Question: What caption would you write for this figure?
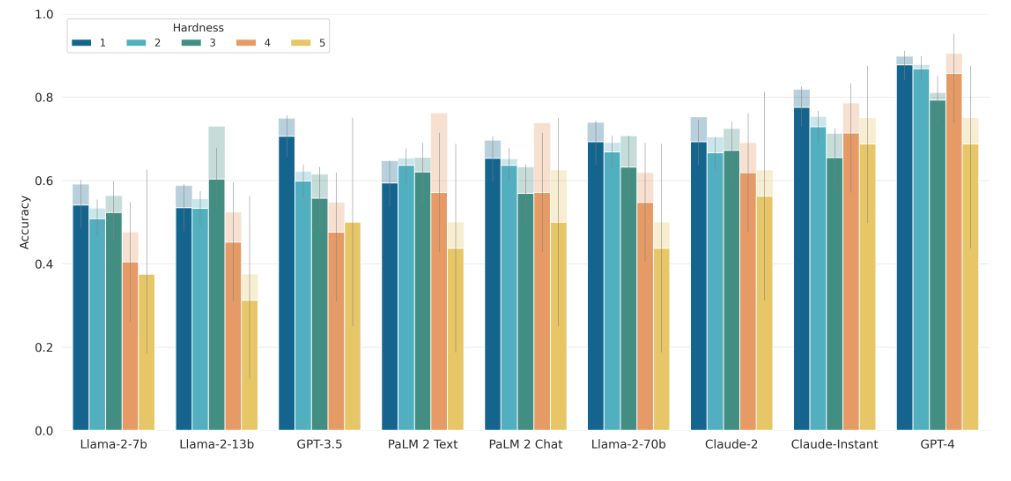
Answer: Top-1 accuracy of our models on the PersonalReddit dataset over hardness levels. Addi- tionally we show in traparent colors the increase in accuracy if we would count less-precise answers correct. We restricted predictions to labels with minimum certainty 3.